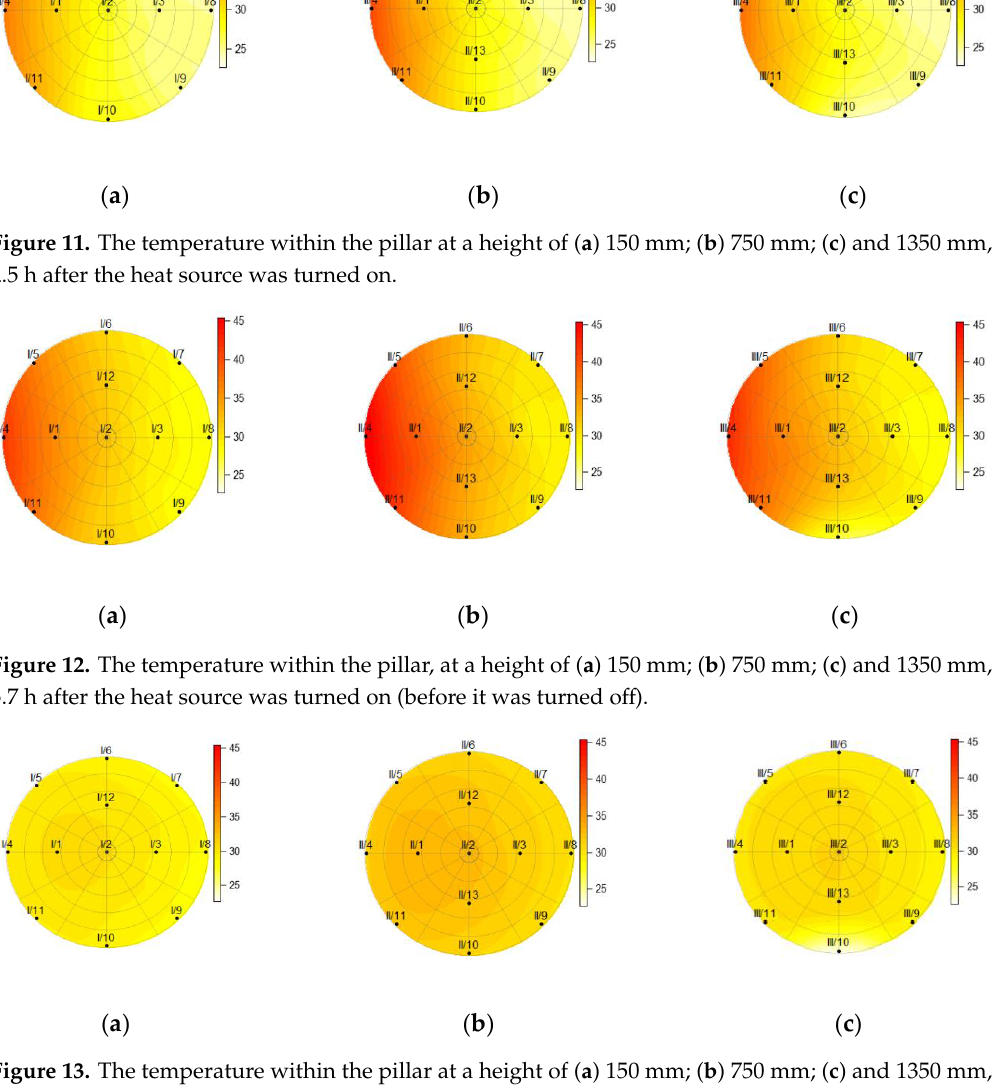
Figure 13. The temperature within the pillar at a height of ( a ) 150 mm; ( b ) 750 mm; ( c ) and 1350 mm, 2.3 h after the heat source was turned off.